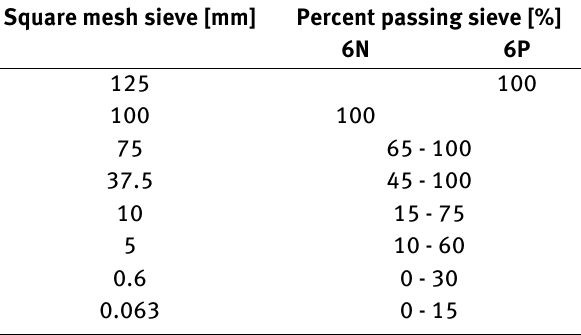
Table 2: Grading of 6N and 6P backfills